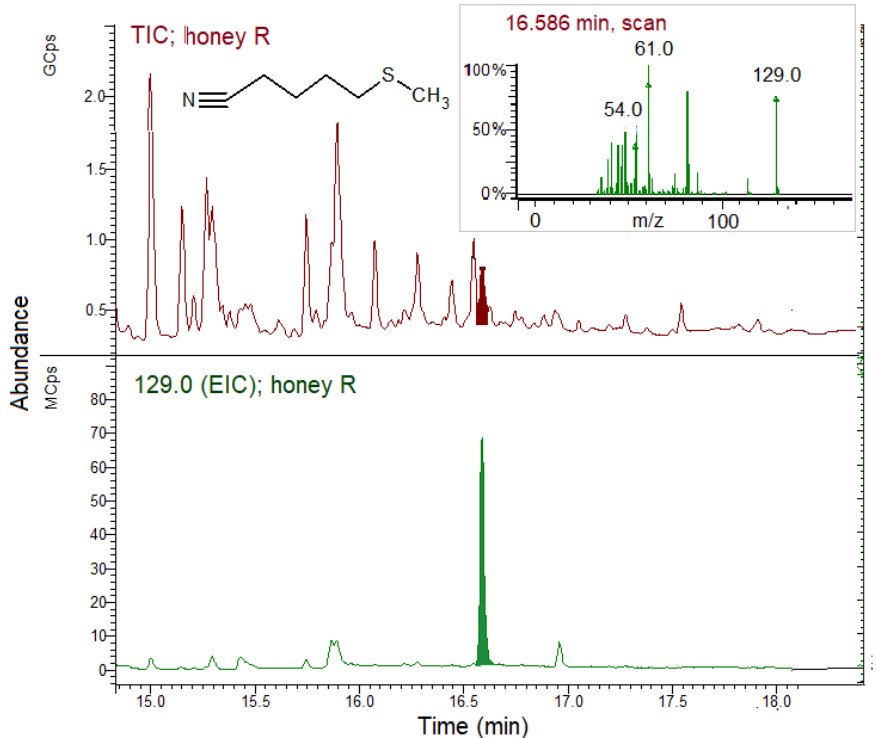
Figure 7. SPME GC–MS analysis of honey produced by the bees fed on E. sativa patties (R group) for 28 days. The chromatograms were expanded to point out the ERN peak. TIC, total ion chromatogram; EIC; extracted ion chromatogram (129.0 m / z for erucin nitrile, ERN). Inset: ERN MS spectrum.